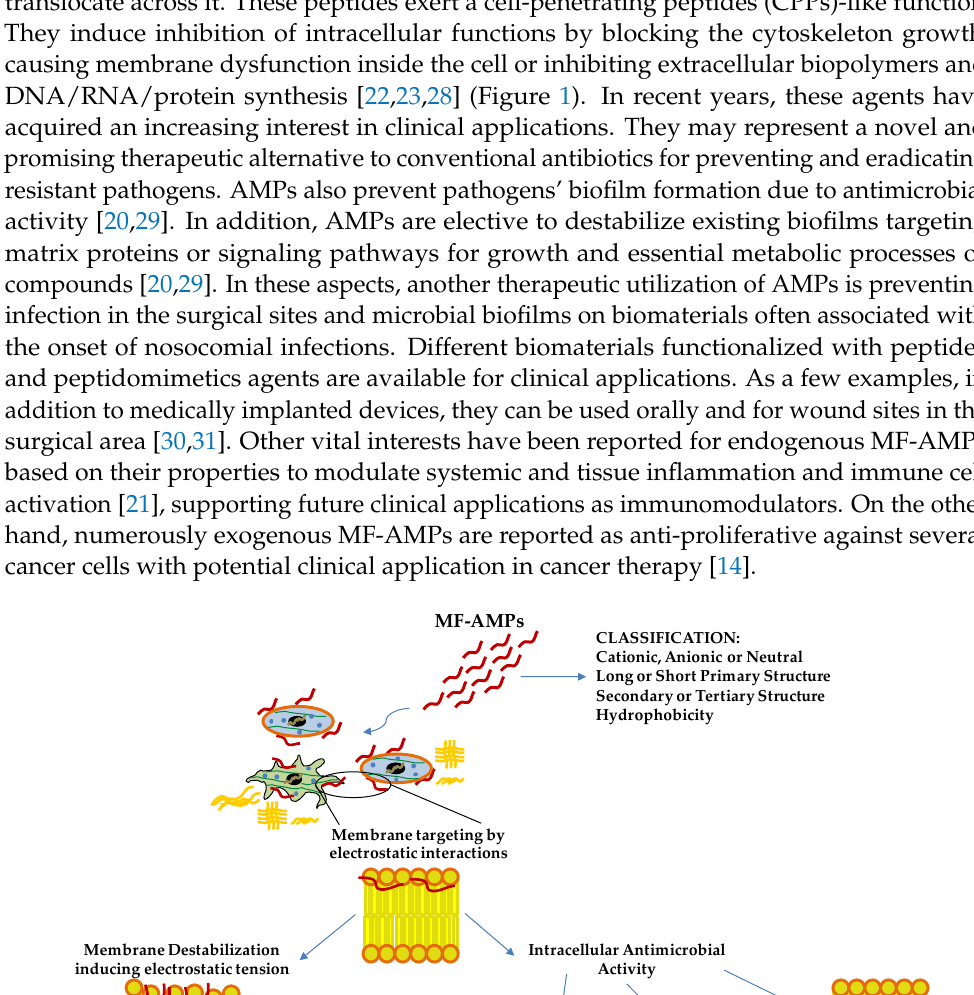
Figure 1. Antimicrobial Mechanisms of Action of Multifunctional Antimicrobial Peptides ( MF-AMPs ). Based on their biochemical characteristics, MF-AMPs can interact with the membrane lipids, inducing the pathogens’ instability and rigidity of the cell membrane. Upon reaching the minimum inhibitory concentration (MIC) values, they cause pore formation and cell lysis. Some MF-AMPs exert a cell-penetrating peptides-like function. They can penetrate the membrane, blocking pathogens’ growth by internal membrane dysfunction, cytoskeleton interaction and interference of biomolecules production. Deoxyribonucleic acid (DNA); ribonucleic acid (RNA).